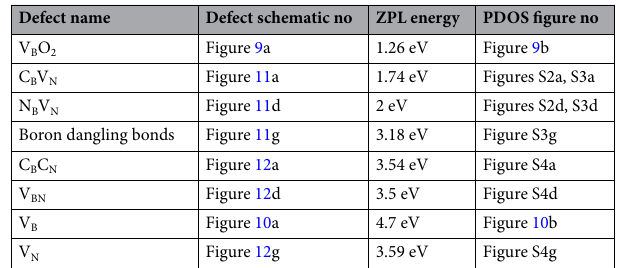
Table 2. Information related to defect type, defect ZPL and correlated PDOS information (simulated work). *S1 and S2 indicates supporting information Figs. 1 and 2,